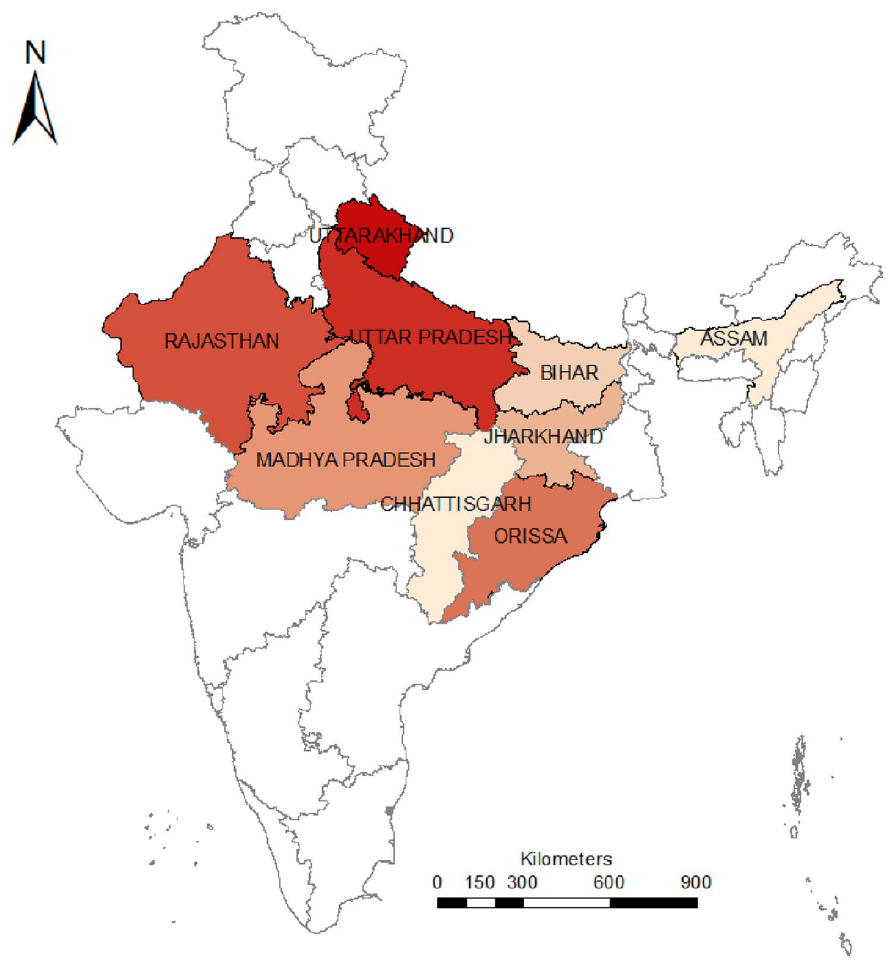
Figure.1. The nine study states in India.